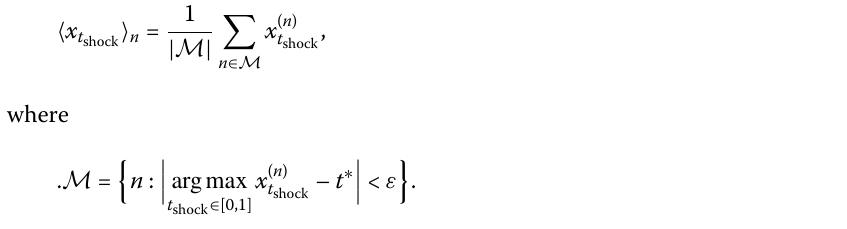
Figure 13 Social dynamics in cusp segments. Extracted cusp Extracted shock segments show diverse behavior corresponding to divergent social dynamics. We extract “important” shock segments (those that breach the top k = 20 ranked weighted shock indicator at least once during the decade under study) and normalize them as described in Sect. 2. We then find the densities of shock points t ∗ 1 , measured using the maxima of the within-window time series, and alternatively measured using the maxima of the (relative) shock indicator function. We calculate relative maxima of these distributions and spatially-average shock segments whose maxima were closest to these relative maxima; we display these mean shock segments along with sample shock segments that are close to these mean shock segments in norm. We introduce a classification scheme for shock dynamics: Type I (panel ( A )) dynamics are those that display slow buildup and fast relaxation; Type II (panel ( B )) dynamics, conversely, display fast (shock-like) buildup and slow relaxation; and Type III (panel ( C )) dynamics are relatively symmetric. Overall, we find that Type III dynamics